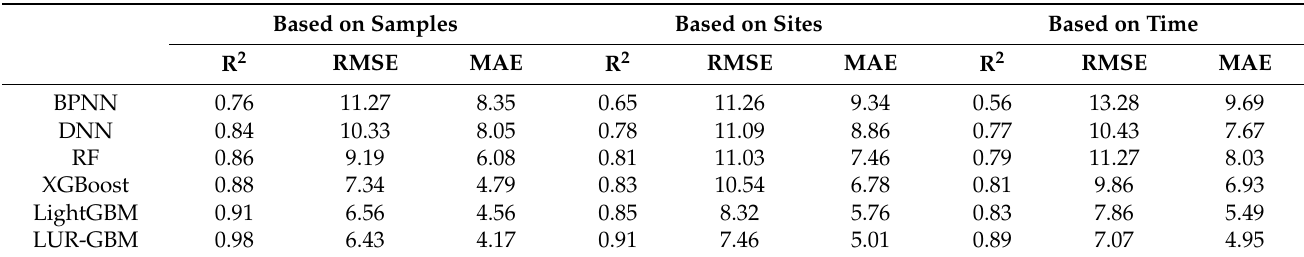
Table 3. Comparison of results of various models. Based on